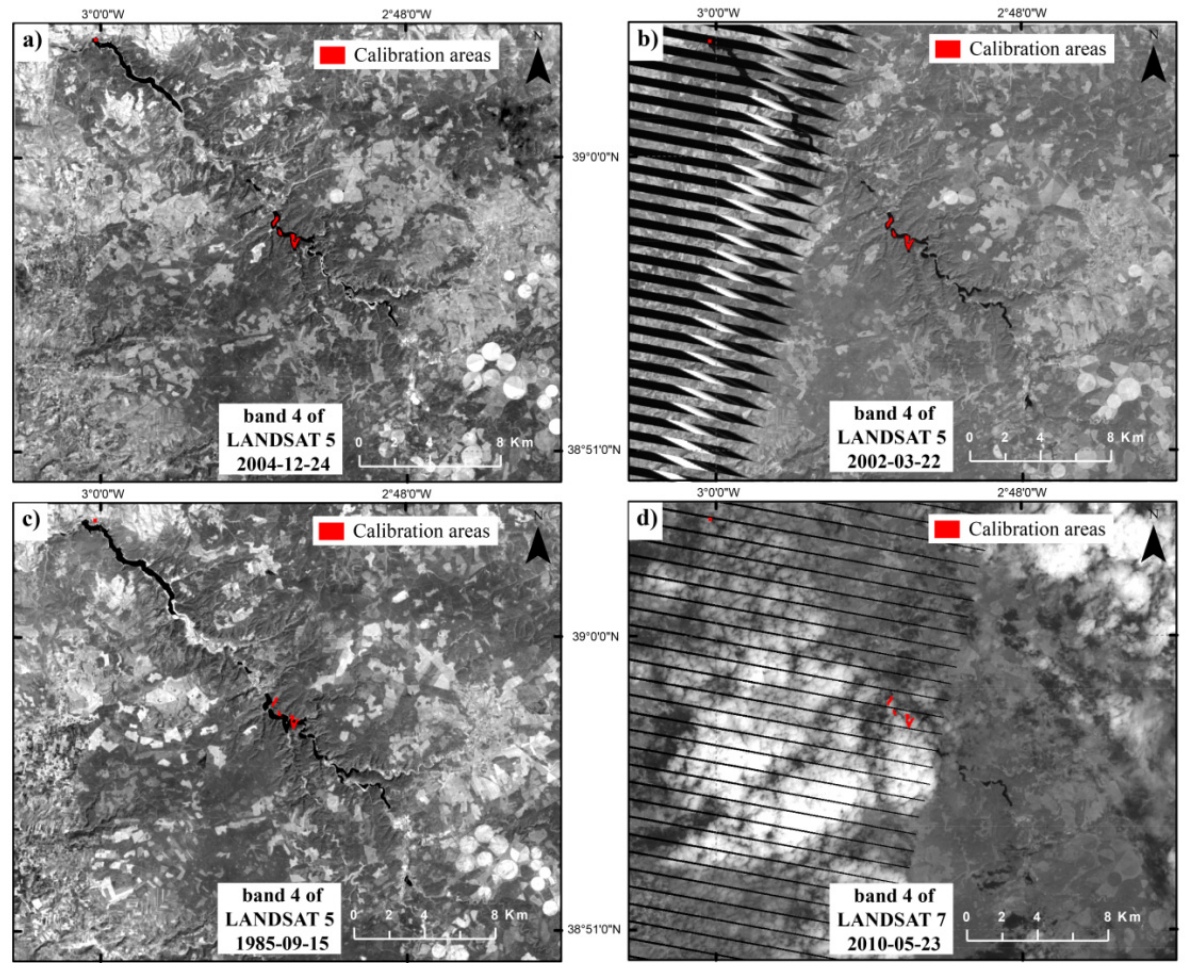
Figure 3 . Surface reflectance maps for the case study and the areas used for calibration: ( a ) image without errors and clouds; ( b ) discarded image due to errors; ( c ) discarded image due to a wrong geo-referenced; ( d ) discarded image due to errors and clouds.